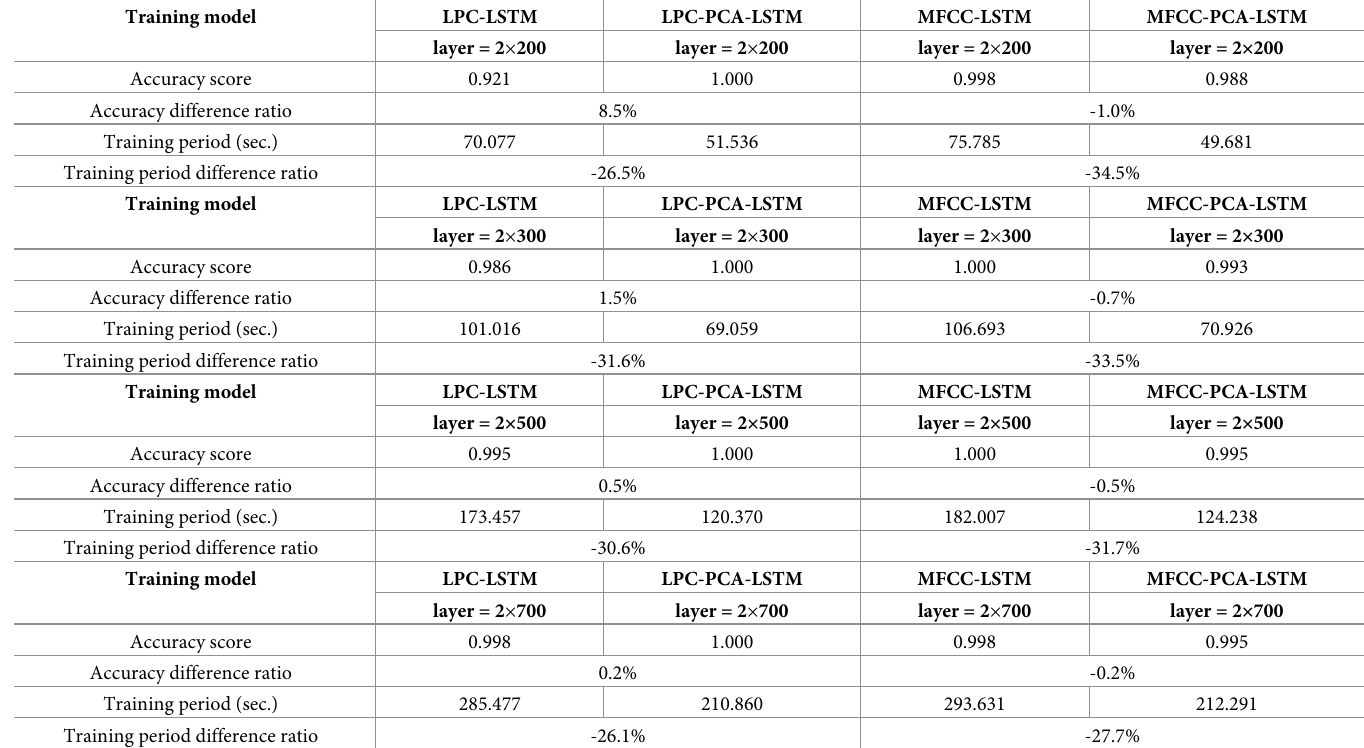
Table 4. Training results of LSTM models and PCA-LSTM models.